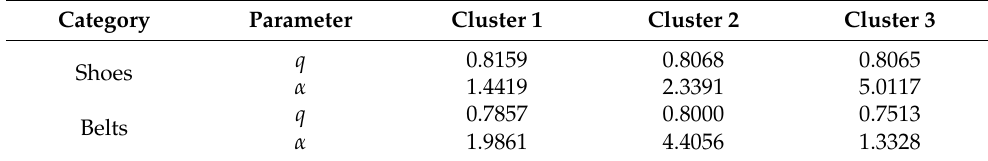
Table 4. Parameter estimates trained on the training set.